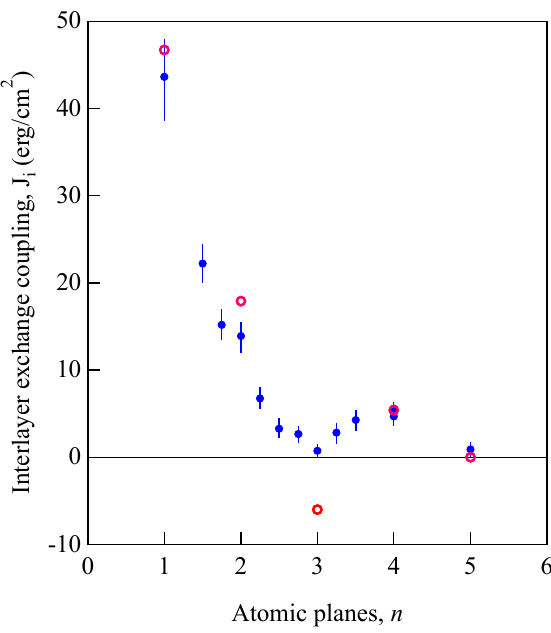
• ) are the BLS results, and the